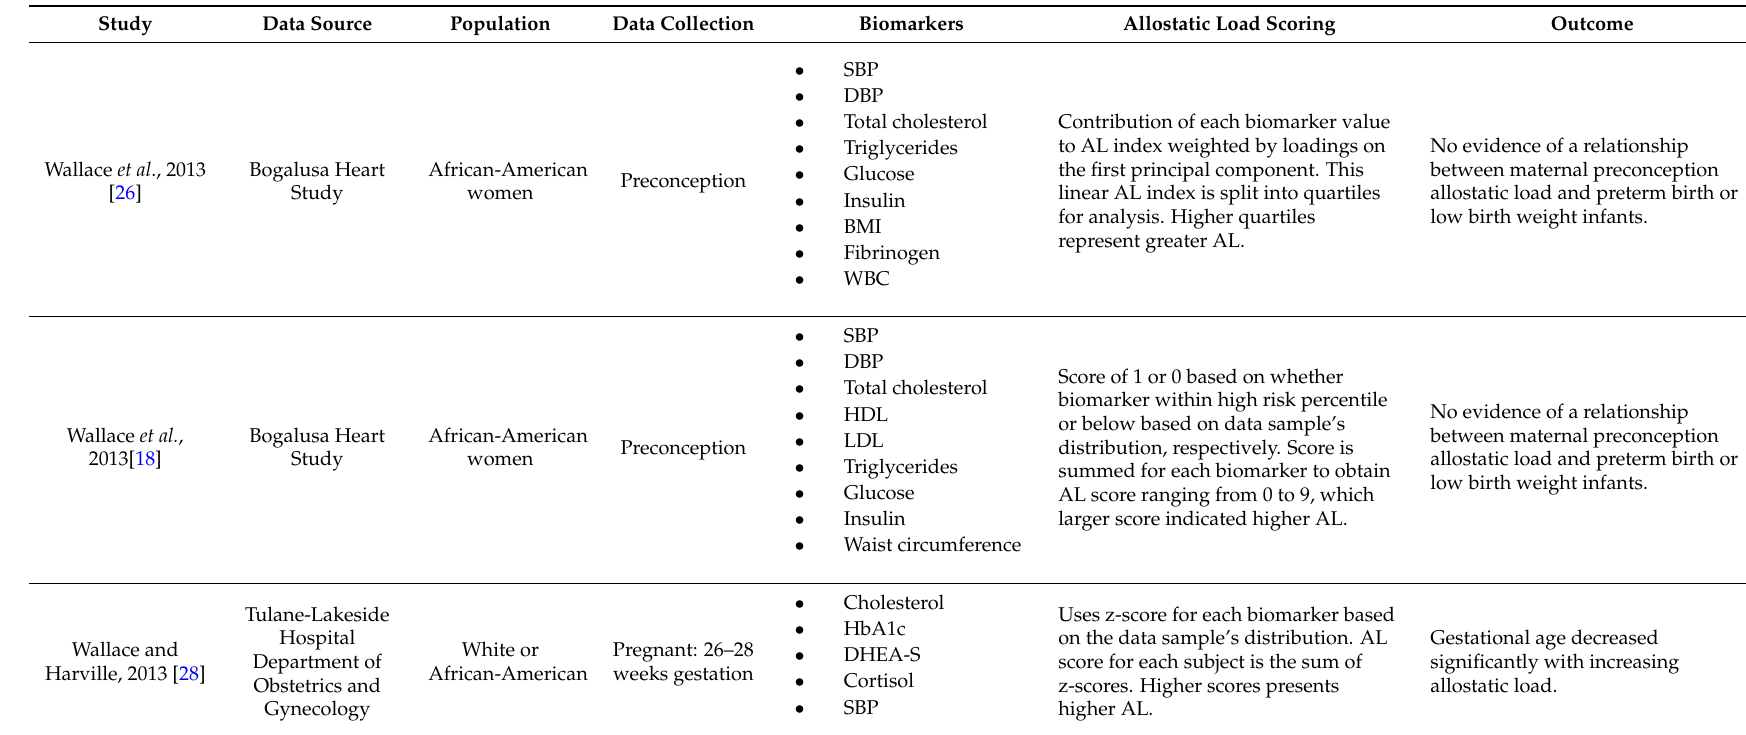
Table 1. Methods used to assess allostatic load in association with pregnancy and birth